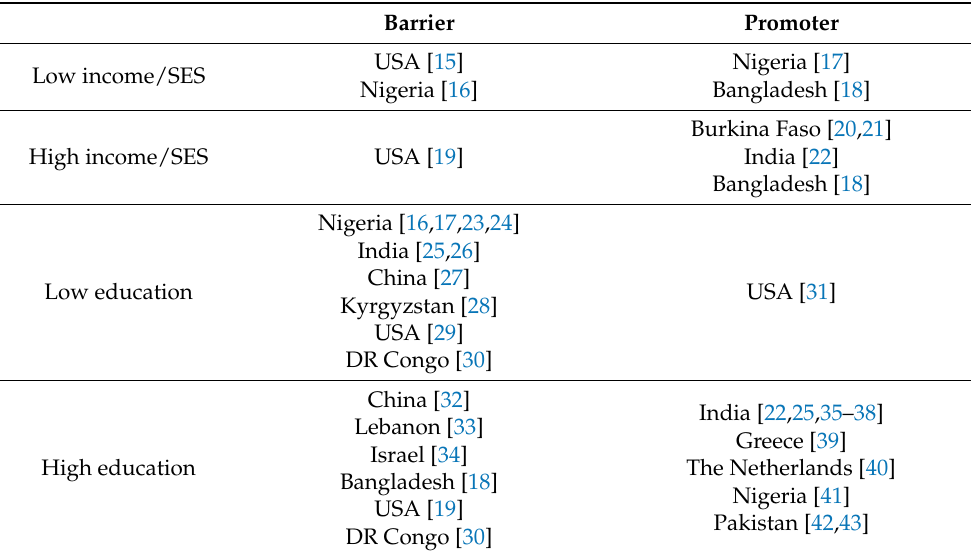
Table 1. Summary of Larson et al.’s systematic review findings